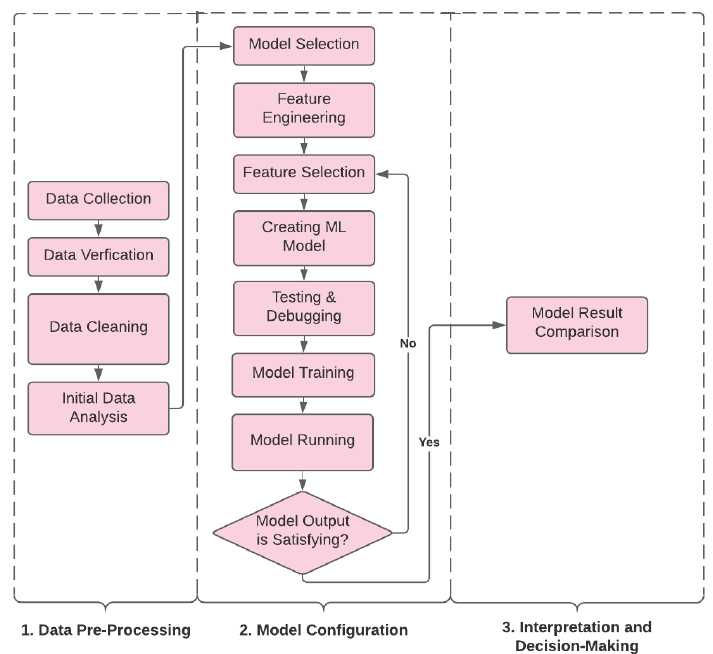
Figure 4. Machine learning model procedure diagram to predict fatigue.